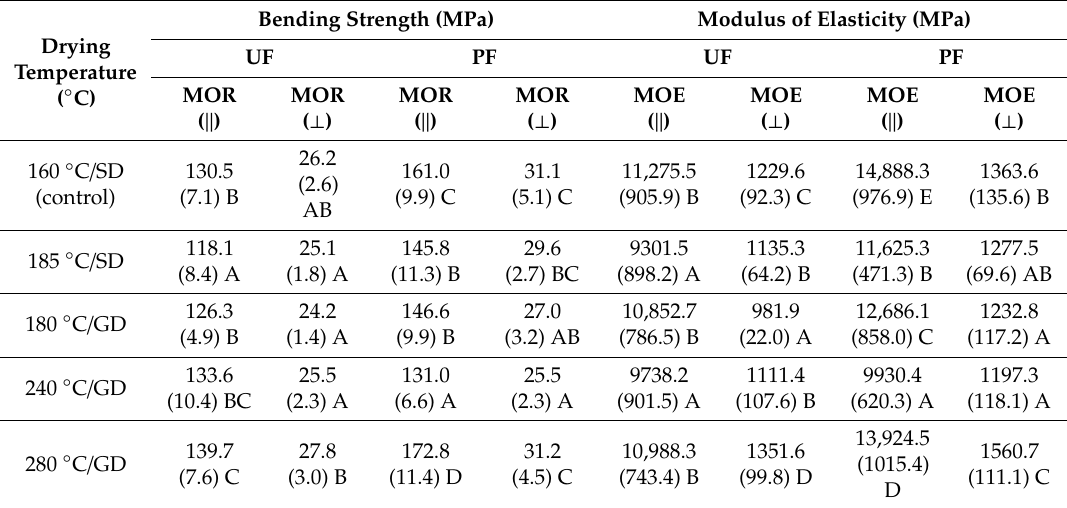
Table 4. Duncan’s test results for selected mechanical properties of plywood